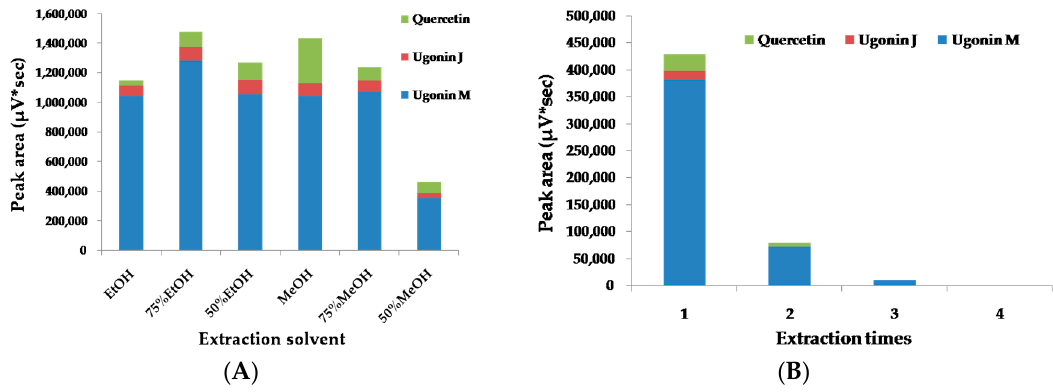
Figure 2. Influence of ( A ) extraction solvent and ( B ) number of extraction times on the extraction efficiency of three analytes in HZ.